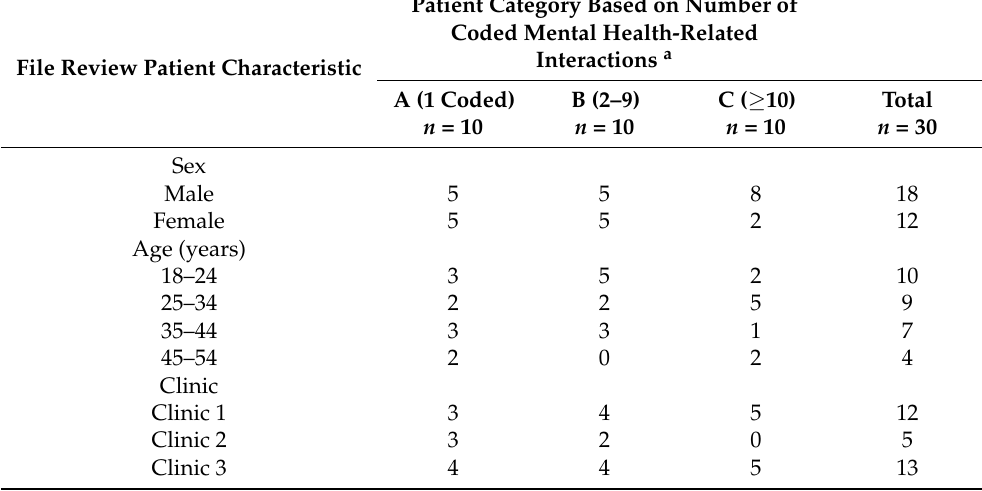
Table 2. Demographics for 30 file review